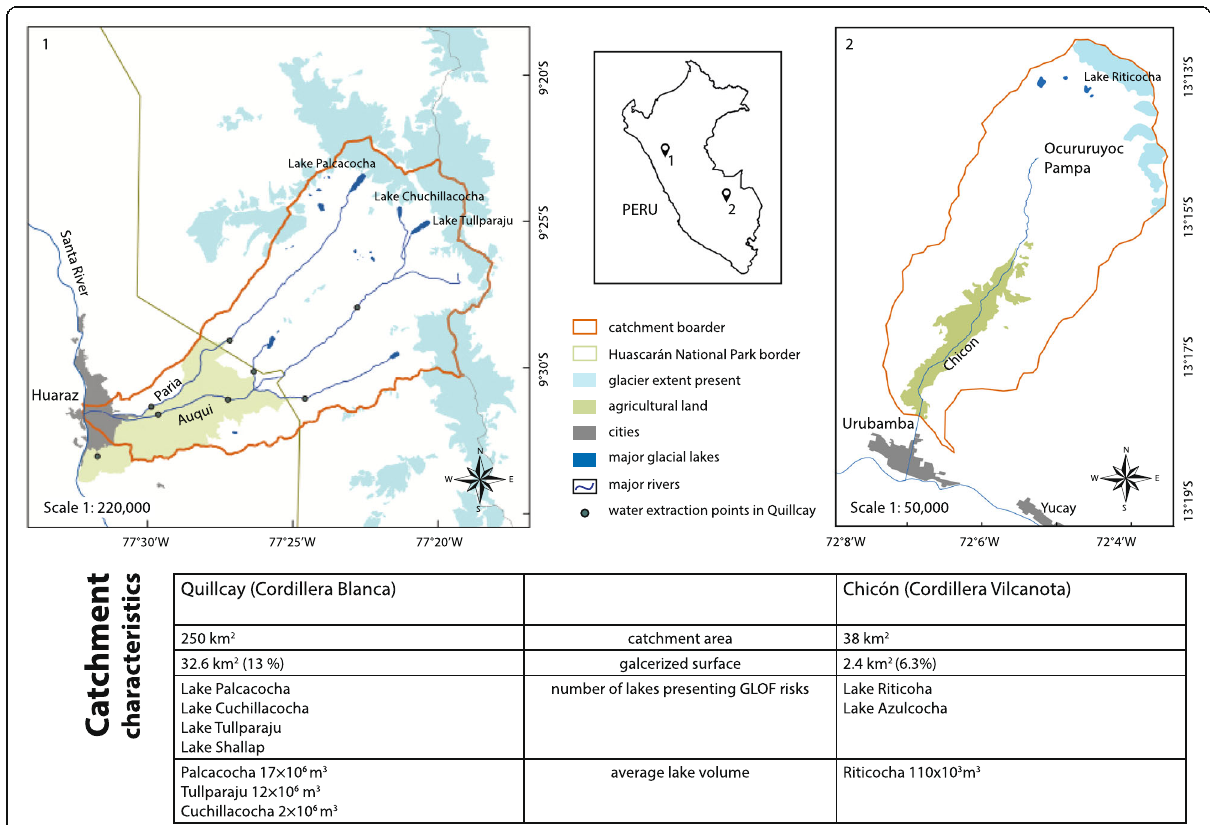
Fig. 1 Study sites (1) Quillcay catchment in the Cordillera Blanca, (2) Chicón catchment in the Cordillera Urubamba and their catchment